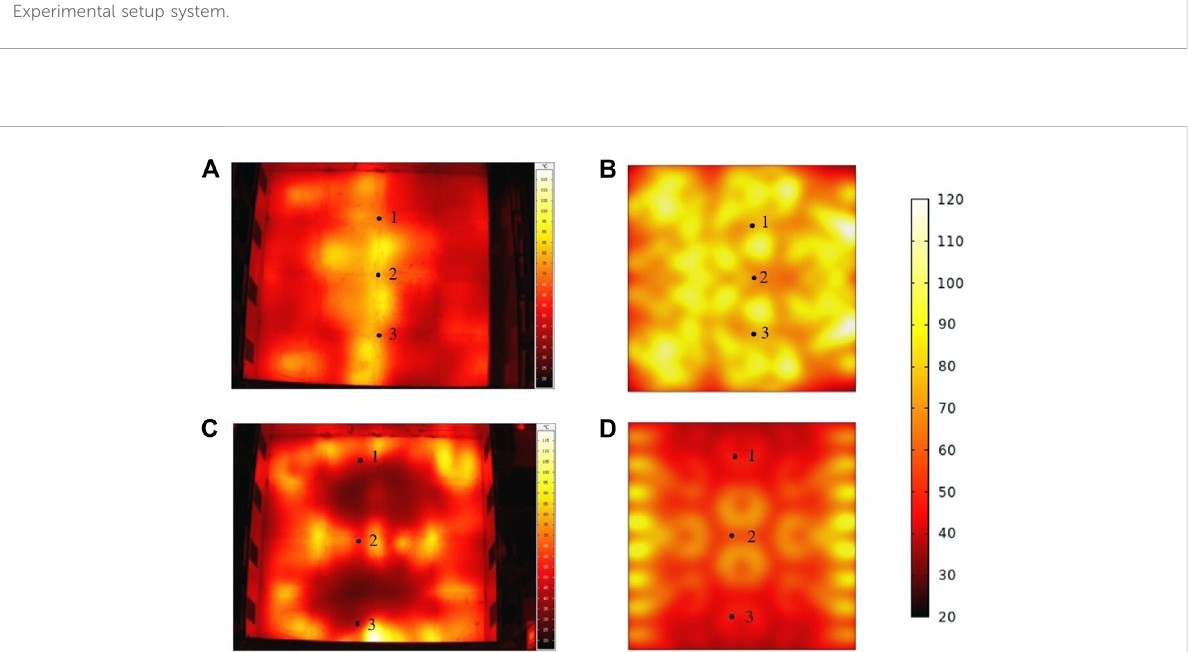
FIGURE 11 Comparison ofthesimulationandexperimentalresults. (A) Experimentaland (B) simulationresultswithaslottedlayerand (C) experimentaland (D) simulation results without a slotted